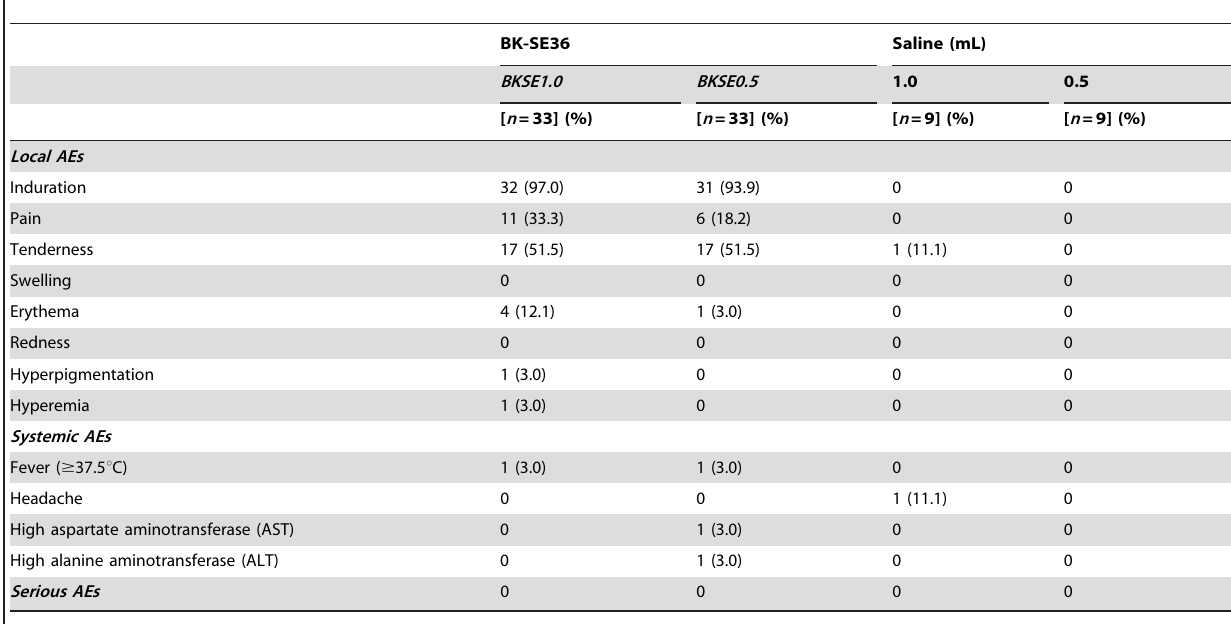
Table 3. Adverse events (AEs) and serious adverse events (SAEs) in 6 to 20 years-old.